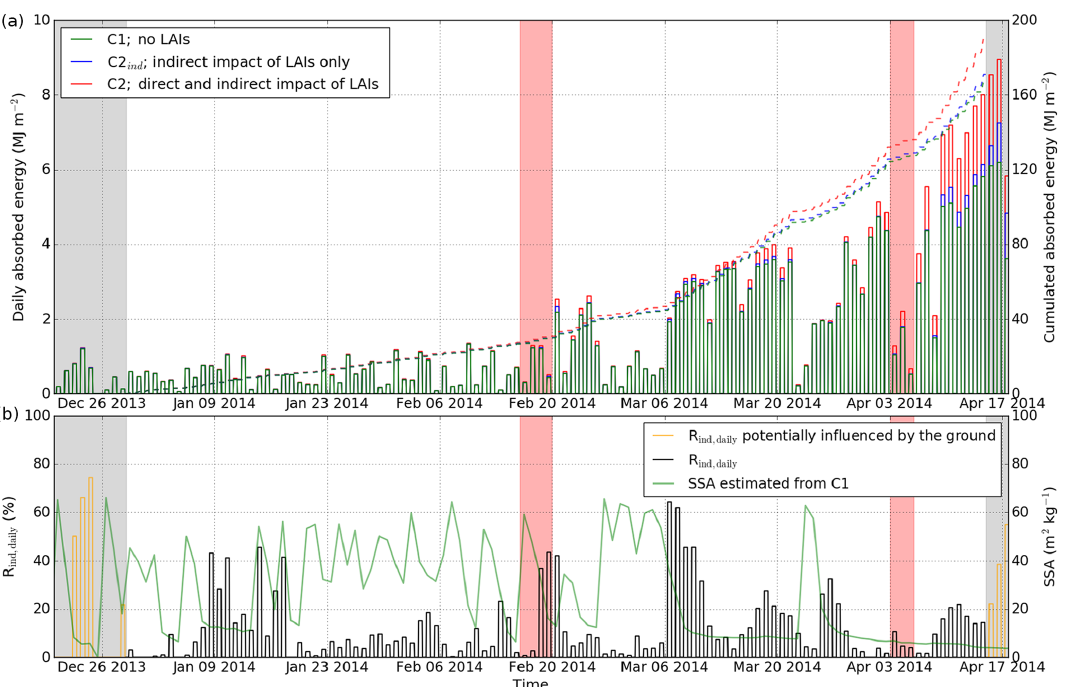
Figure 7. Energy absorbed by the snowpack during the season (a) ; the full lines correspond to the daily amount of energy absorbed whereas the dashed lines correspond to the cumulative energy absorbed over the study period. R ind , daily compared to near-surface SSA computed from C1 (b) ; R ind , daily is the daily relative importance of LAIs in snow radiative forcing coming from the indirect impact (Eq. 5 applied to daily energy absorption). The dates during which the ground influences the energy budget have been masked (grey shading). The red shading represents two major Saharan dust